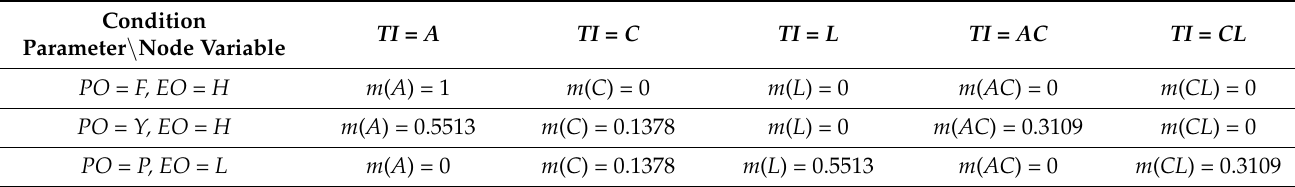
Table 4. Conditional belief parameters of node TI